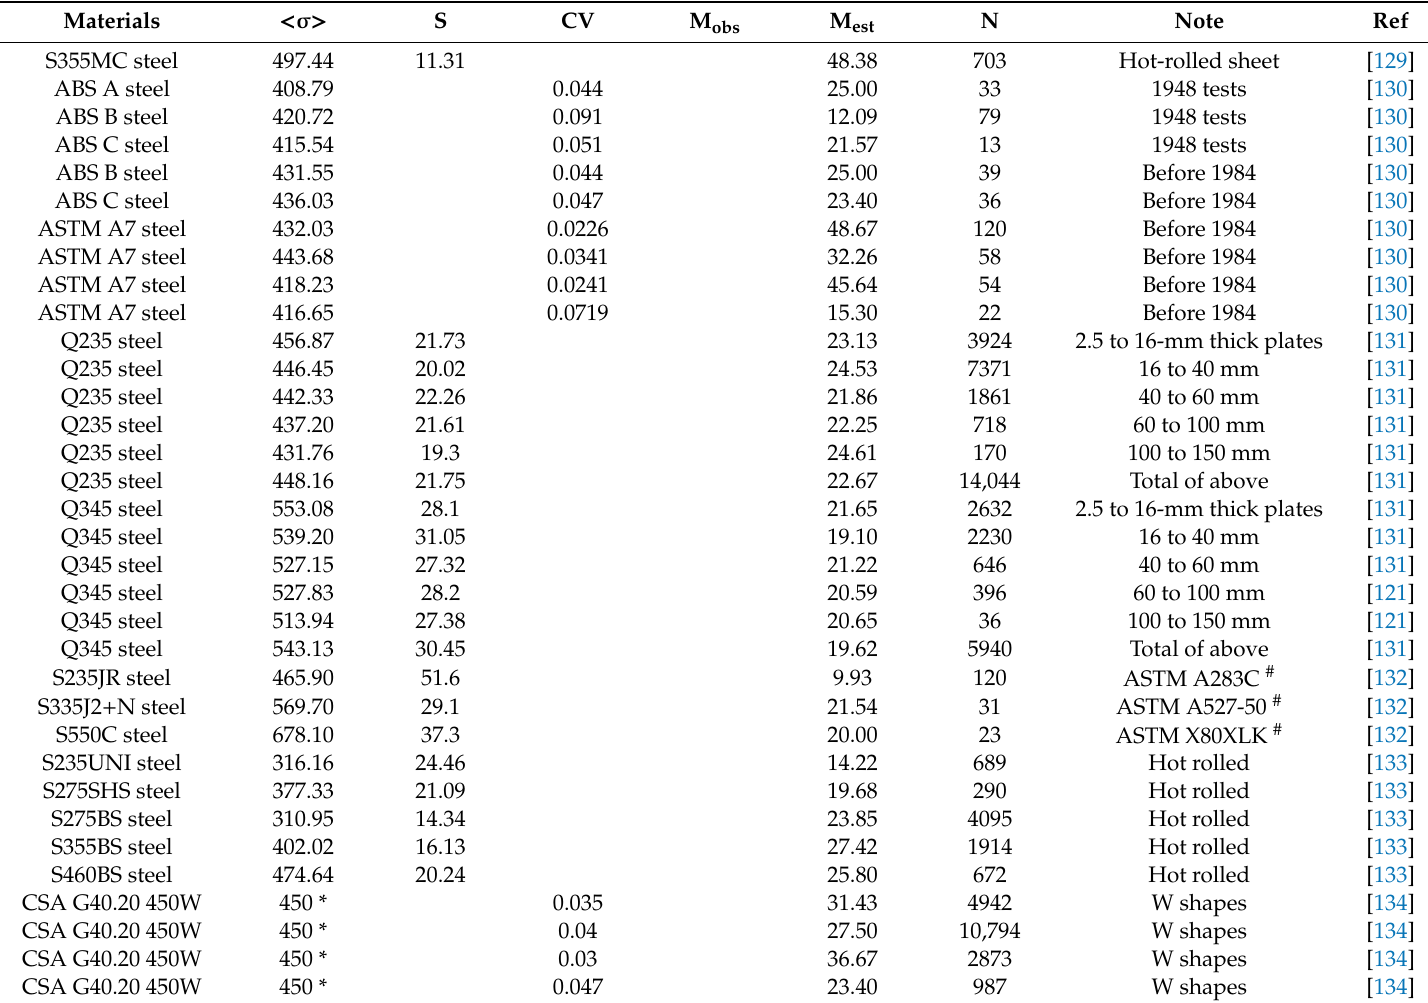
Table 8. Listing of large-scale data for estimated m values using S or CV and for observed